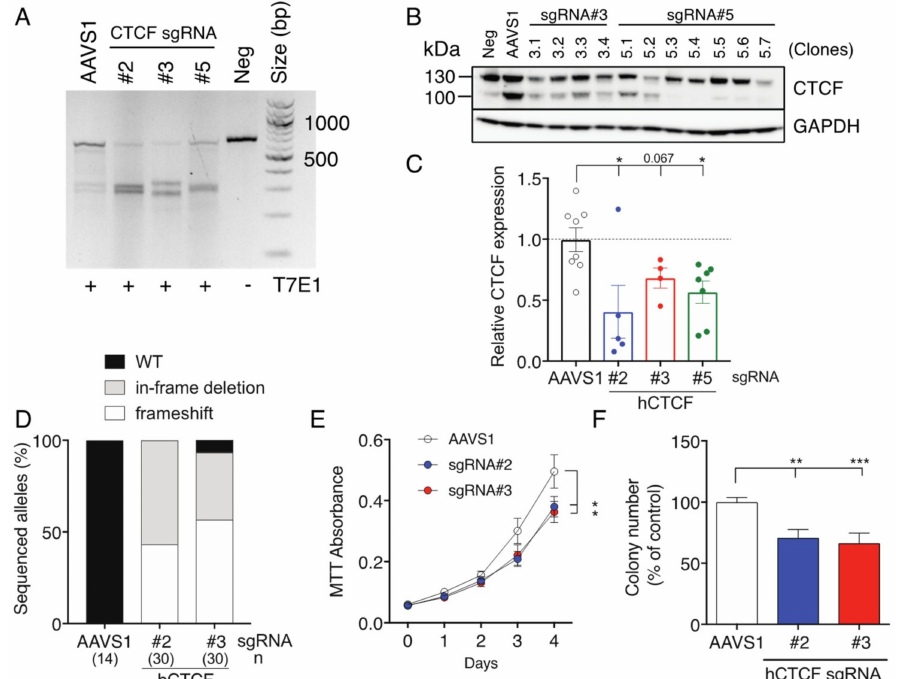
Figure 2. Inhibition of cell proliferation and clonogenicity following CRISPR/Cas9 targeting of CTCF in K562 cells. K562 cells were transduced with Cas9 and sgRNA-containing lentivectors (AAVS1 sgRNA = control; human CTCF exon 3 sgRNAs #2, #3, #5) and enriched for eGFP + mCherry + cells using FACS; Neg = untransduced K562 cells. ( A ) CTCF exon 3 PCR amplification and T7 endonuclease I (T7EI) digestion: approximate expected sizes (in bp) for digested products #2 (310, 345), #3 (296, 359) and #5 (323, 332). Analysis of CTCF protein levels in K562 clones: ( B )